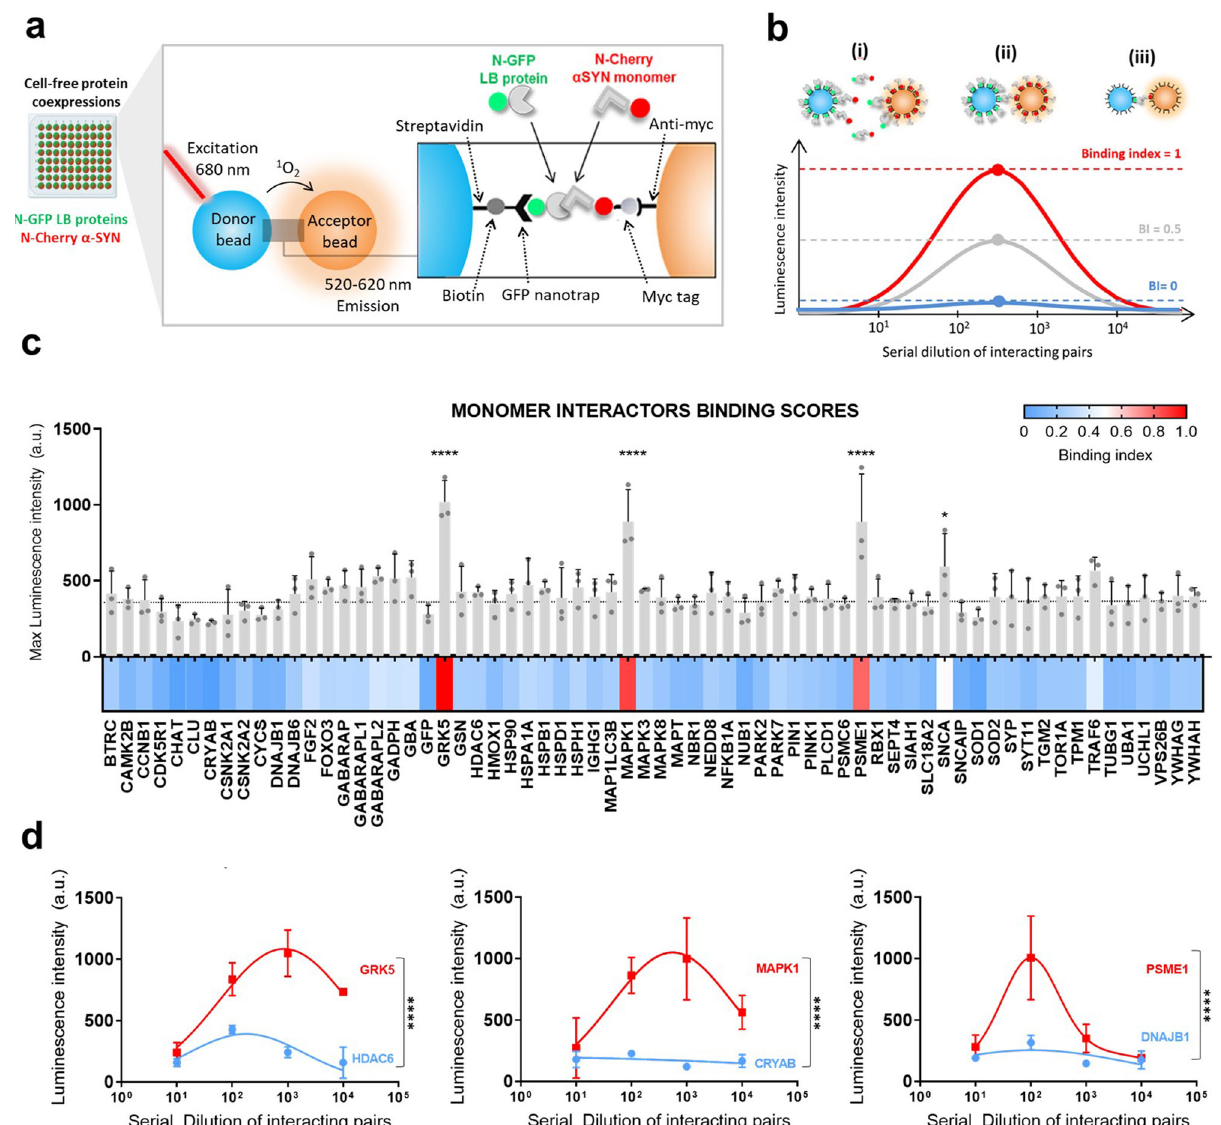
Fig. 2 Interactions between LB proteins and monomeric WT α -SYN. a All proteins and a GFP control were co-expressed in LTE with N-mCherry-tagged WT α -SYN. LTE was primed with the DNA constructs of each LB protein and α -SYN in a 96-well plate. The donor bead binds the N-GFP-tagged LB protein while the acceptor bead binds to the N-terminal mCherry-myc tag of α -SYN. Upon interaction, the proteins will bring the beads in close proximity with the transfer of a singlet oxygen, leading to signal being emitted at 520 – 620 nm. b AlphaScreen signal is dependent on the dilution of the protein. An excess of proteins (i) will lead to a low signal by inhibition of bead association through competition with unbound proteins, whereas low concentration leads to limited bead association (iii). A maximum signal is detected when the optimal bead/protein ratio is reached (ii). Maximum luminescence is then converted to a binding index (BI) for each interaction. c Maximum values were plotted as a bar plot, with error bars representing the SEM of the triplicate measurements. Dotted line represents mean + SEM of GFP control. Heatmap represents the BI values. d AlphaScreen curves along the four dilutions. Comparison of signals to those of the GFP control (Dunnett ’ s multiple comparisons test; **** p ≤ 0.0001, * p ≤ 0.05, n = 3). Error bars = mean ±